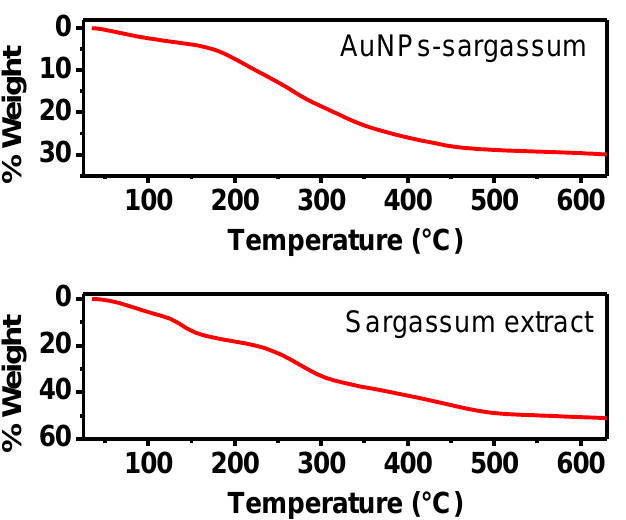
Figure 6. TGA analysis of AuNPs synthesized with water/ethanol Sargassum spp. extract.